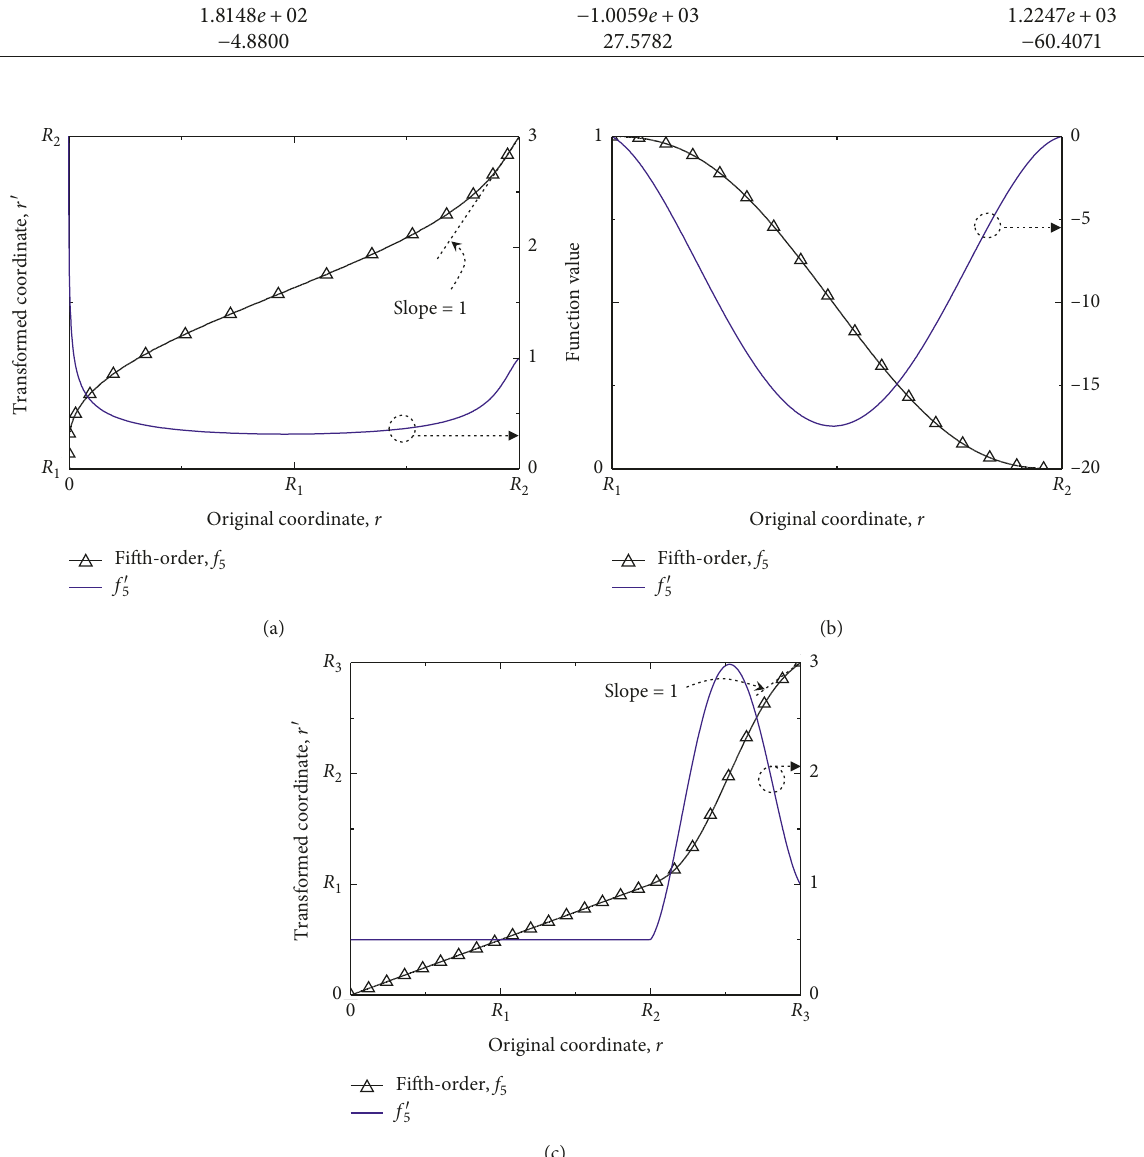
Figure 4: Proposed fifth-order transformation function: (a) the cloak, (b) the rotator, and (c) the concentrator. The function had smaller changes near boundaries compared with f 3